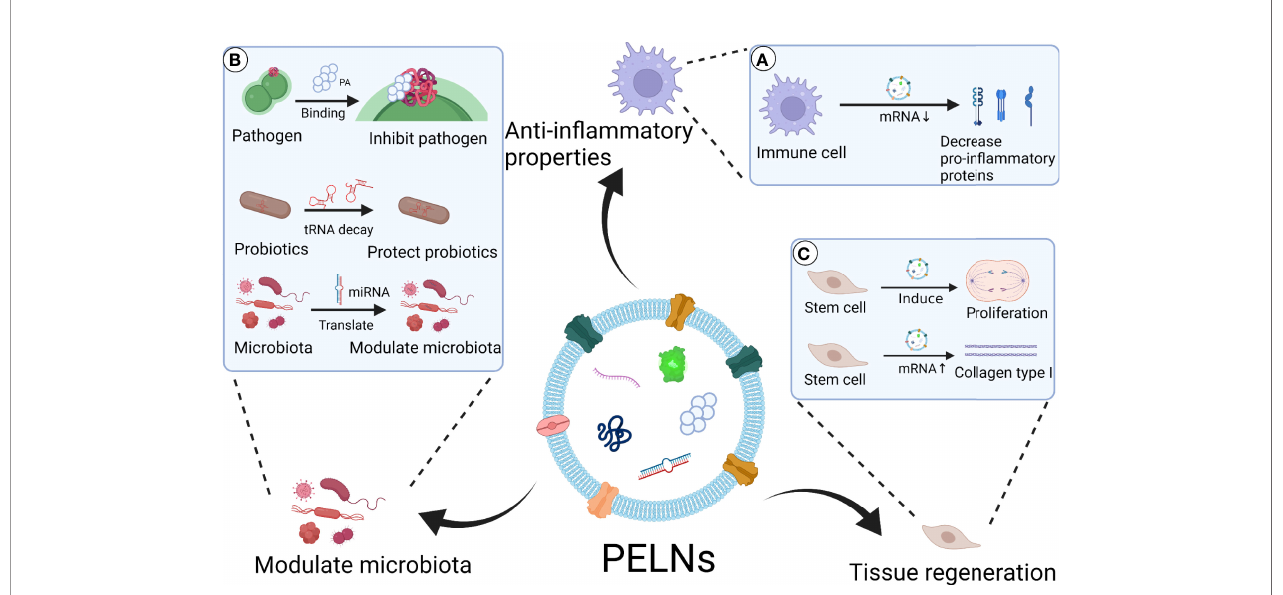
FIGURE 4 | Scheme of PELNs ’ possible application in the treatment of periodontitis. PELNs show therapeutic potential for periodontitis via anti-in fl ammatory effect, microbiota modulation, and tissue regeneration. (A) Anti-in fl ammatory properties: PELNs inhibit pro-in fl ammatory protein expression in macrophages, such as IL-1 b , IL-6, and TNF- a (55). (B) Modulate microbiota: PELNs inhibit pathogenic bacteria such as P. gingivalis through PA binding to HBP35 (19). PELNs protect probiotics through decay tRNA in probiotics (93). PELNs transform miRNA to microbiota, which has the potential to modulate oral microbiota. (C) Tissue regeneration: PELNs promote the proliferation of stem cells through activation of Wnt signals (30, 114). PENLs promote the production of collagen type I in epithelial cells (95).Created with